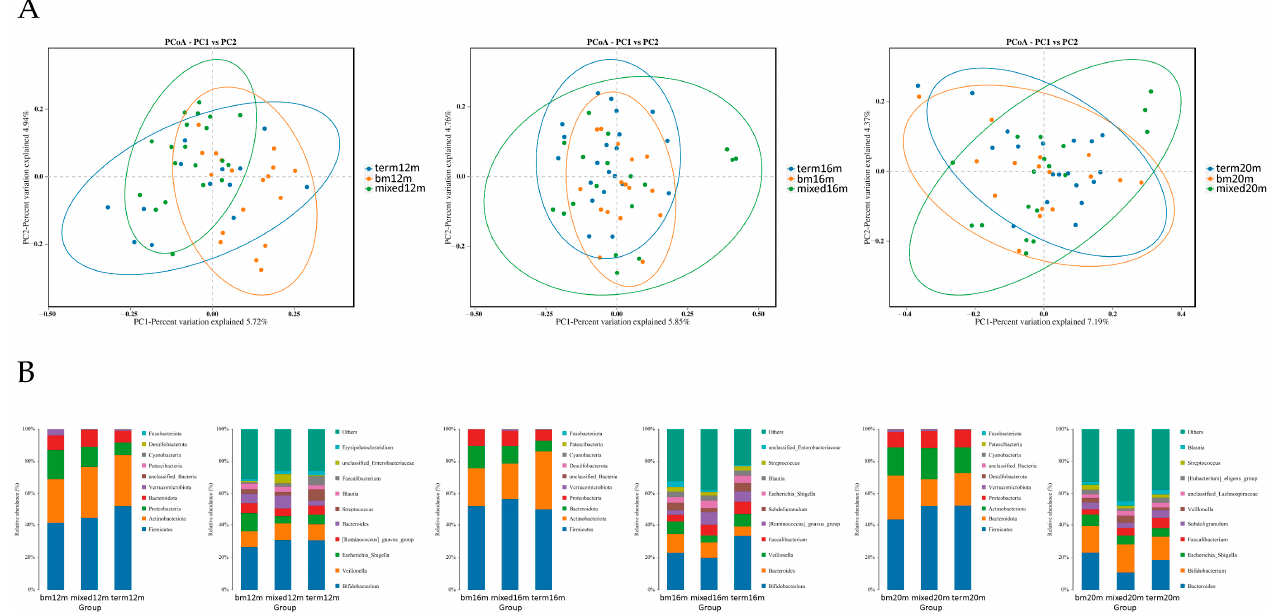
Figure 3. Gut microbiota community structure in each group varied by feeding mode at different sampling times. ( A ) Binary Jaccard distances displayed by PCoA plots at 12 months, 16 months and 20 months; ( B ) relative abundance at phylum level and genus level at 12 months, 16 months and 20 months. Figure legend: bm, breast milk; m, months.